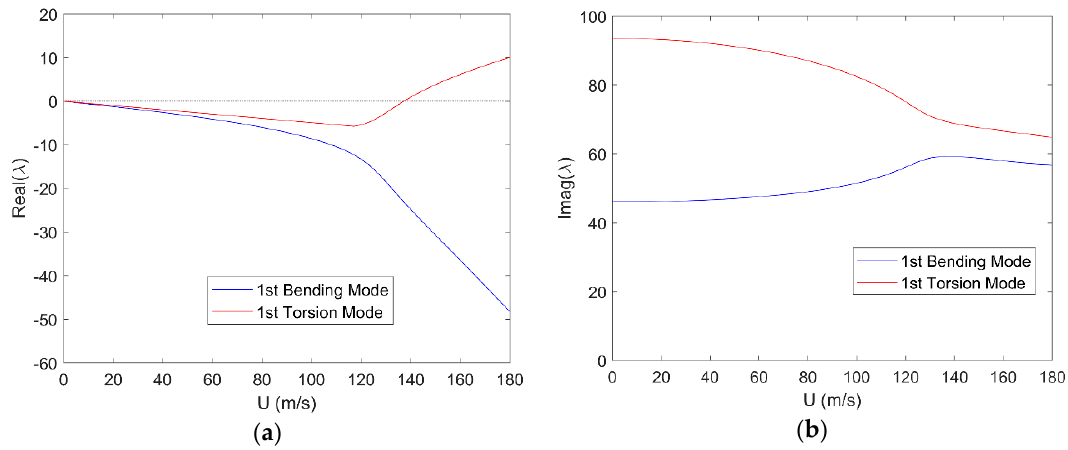
Figure 1. Real ( a ) and imaginary ( b ) parts of the first two eigenvalues for Goland’s wing flutter.